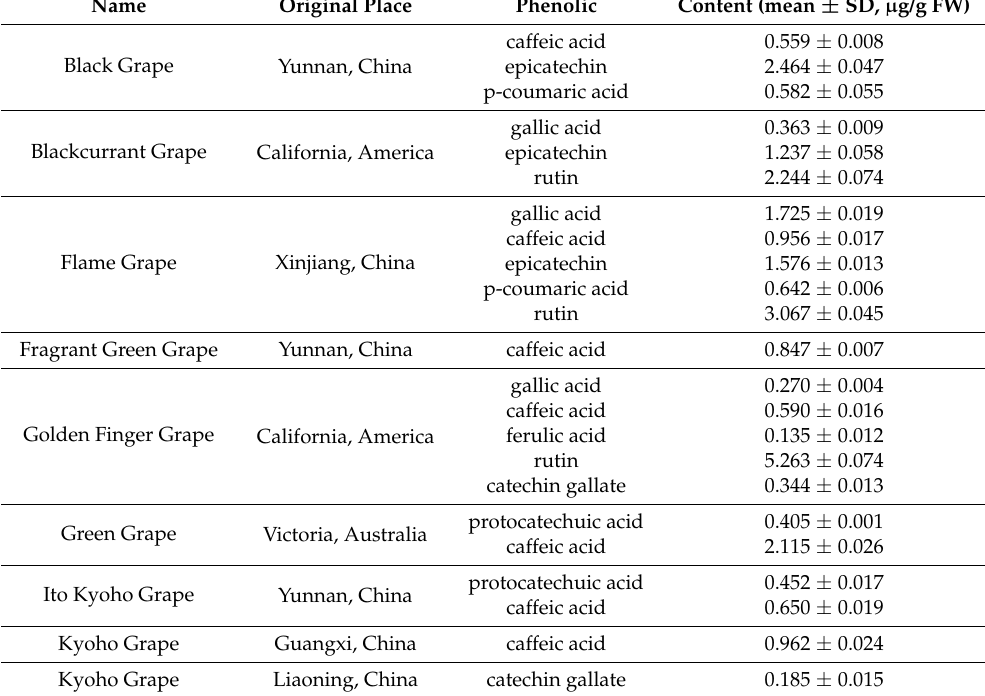
Figure 5. Chromatograms of the standard compounds ( A ) and grape pulp ( B ) under 276 nm. The numbers in brackets refer to the compounds: gallic acid (1); protocatechuic acid (2); gallo catechin (3); chlorogenic acid (4); cyanidin-3-glucoside (5); caffeic acid (6); epicatechin (7); catechin gallate (8); p-coumaric acid (9); ferulaic acid (10); melatonin (11); 2-hydroxycinnamic acid (12); rutin (13); resveratrol (14); daidzein (15); equol (16); quercetin (17); genistein (18). Table 2. Main phenolic compounds and their contents in pulps of 30 grape varieties.